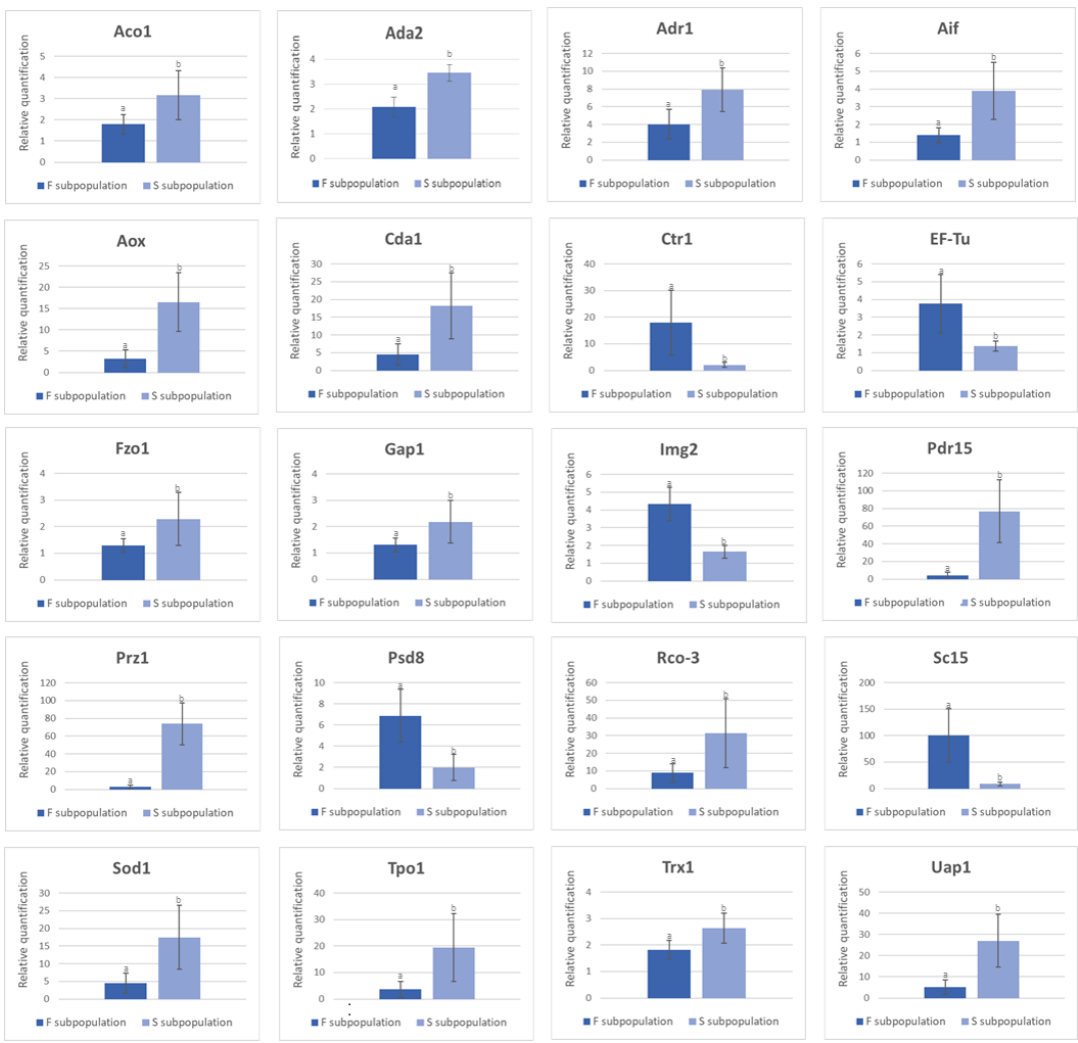
Figure 4. RT-qPCR validation of differentially expressed genes in monokaryons of F- and S-subpopulations. The results are reported as mean ± standard deviation (SD) of nine fast (F-subpopulation) and nine slow (S-subpopulation) growing monokaryons. Actin1 , Gaph1, and Sar1 were used as reference genes. Three biological replicates were used for each monokaryon. Genes are represented by their abbreviation, as indicated in Table S1. Lower-case letters indicate statistically significant expression differences between F- and S-subpopulations (Student t -test, p -value < 0.005).